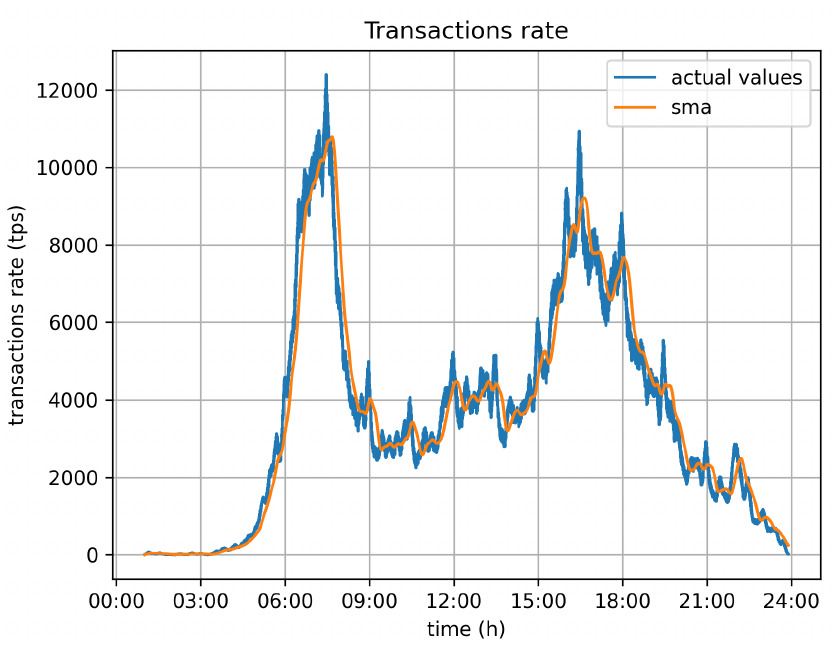
Figure 8. Transactions rate (initial).